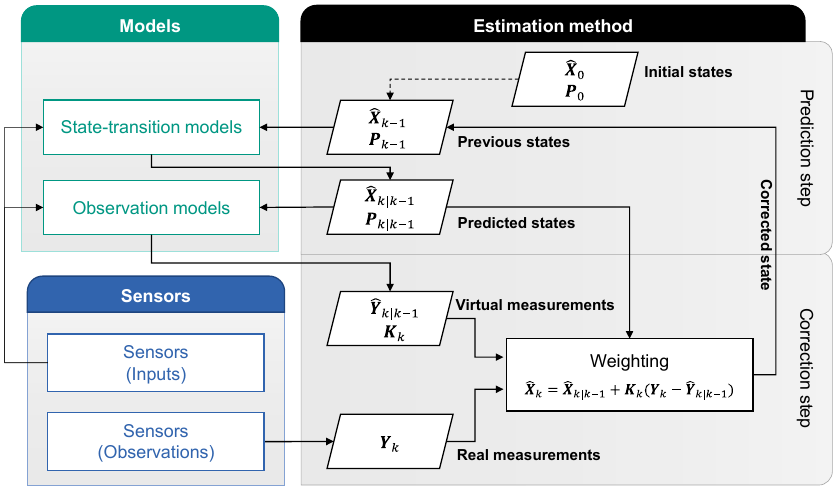
Figure 3. Functional sequence of a state estimator.